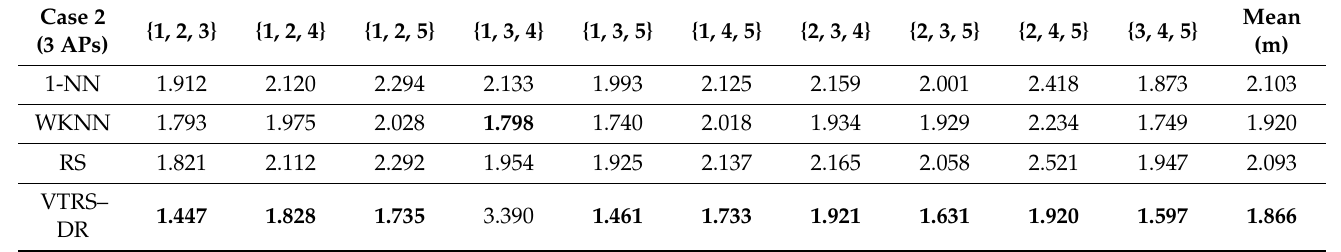
Table 11. Mean errors of using three APs in Case 2.